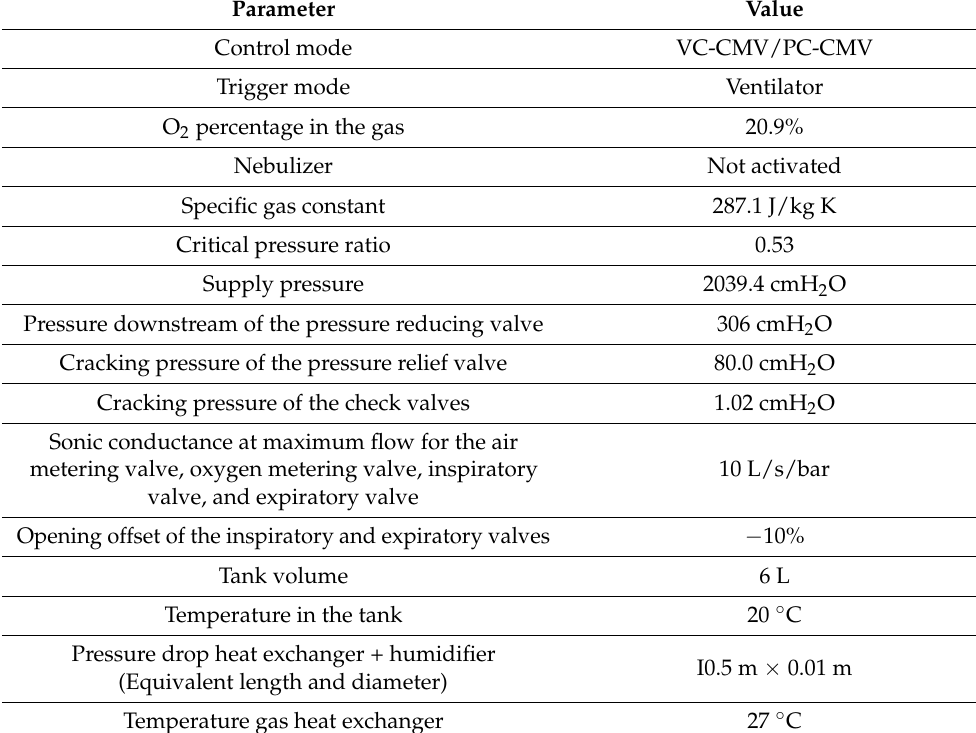
Table 4. Operating and geometrical parameters of the